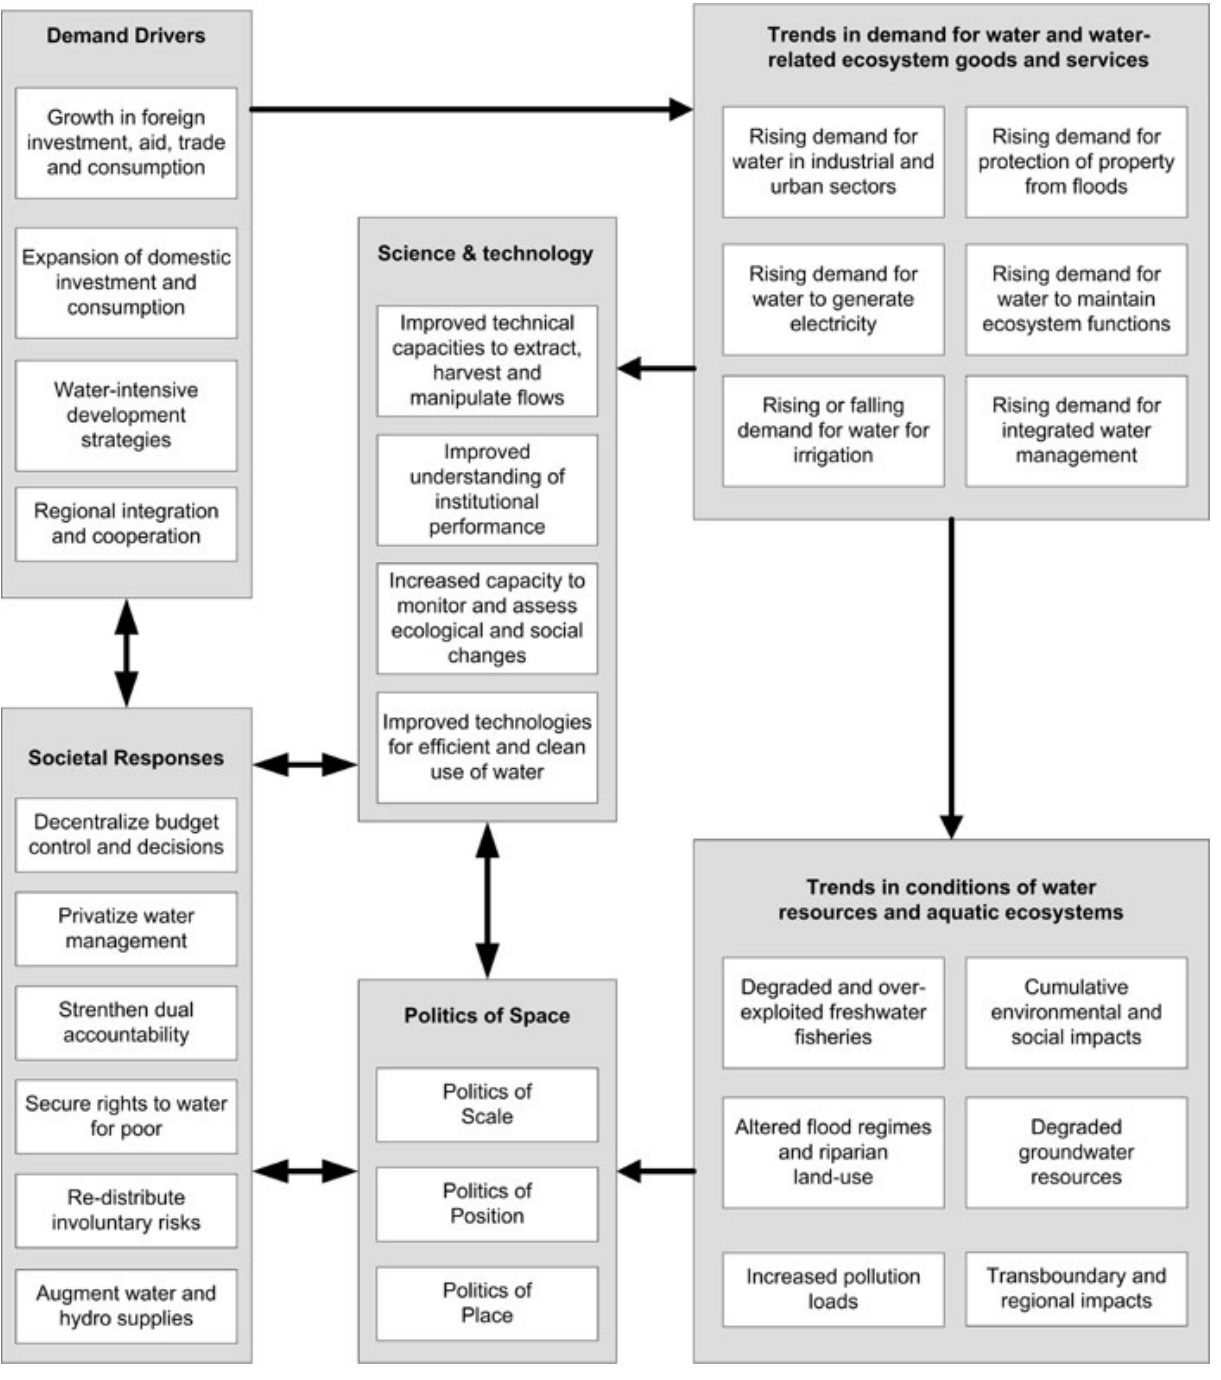
Fig. 3. A conceptual model of some of the main dynamic processes driving water and water-related resource politics in the Mekong